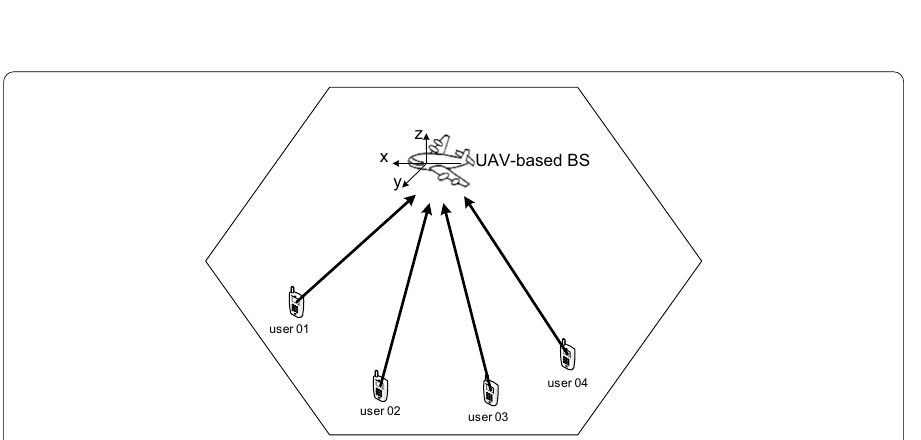
Fig. 2 System model of UAV-based BS in cell. Depicts a system model of users’ signals reaching UAV-based BS in a